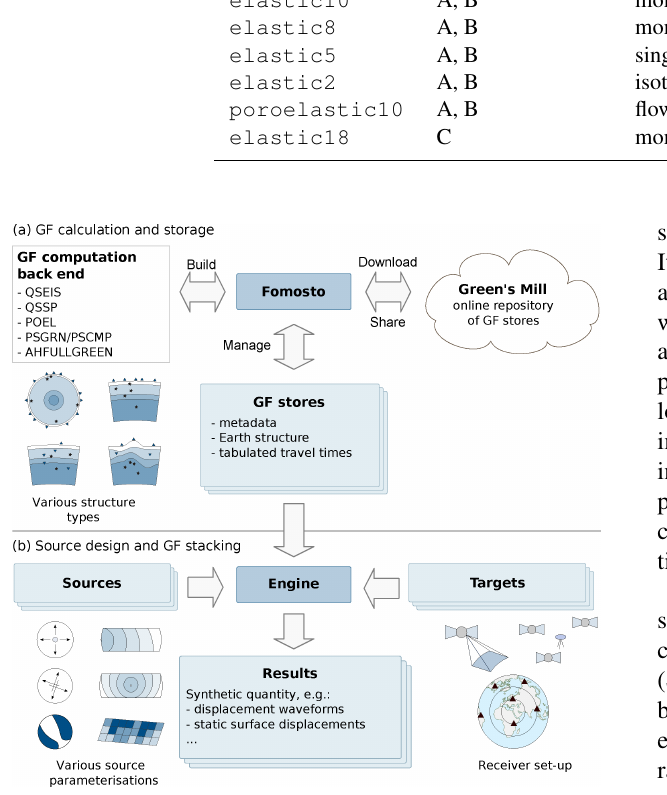
Figure 2. The architecture of Pyrocko-GF and the object-oriented implementation scheme. (a) The fomosto program is a command- line interface (CLI) to create GFs using the back ends to inspect and manage GF stores. (b) The engine is the central object that accesses the computed Green’s function stores and calculates the synthetic waveforms based on the specified source (e.g. moment tensor, double-couple source, or finite rectangular) and targets (e.g. virtual seismometers, GNSS stations, or InSAR line-of-sight dis-